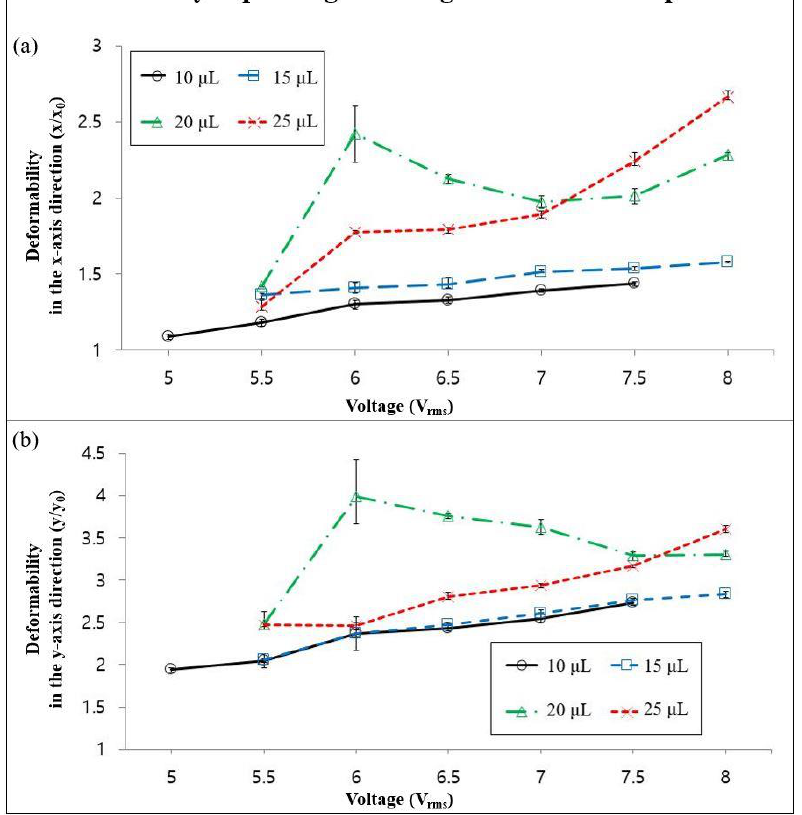
Figure 4. The deformability of liquid metal droplets in the ( a ) x and ( b ) y -axis direction, depending on the voltage of the acoustic wave for the piezo-actuator.